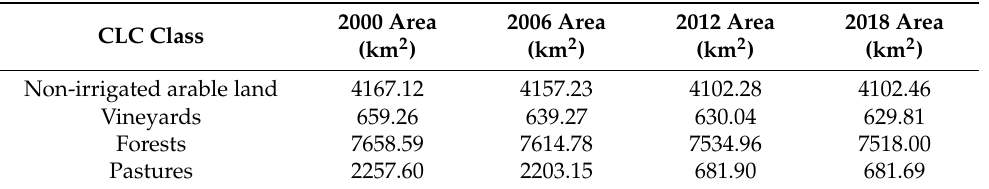
Table 5. CLC class area computed for 2000, 2006, 2012, and 2018 years according to the correspondent CLC Land use/Land cover